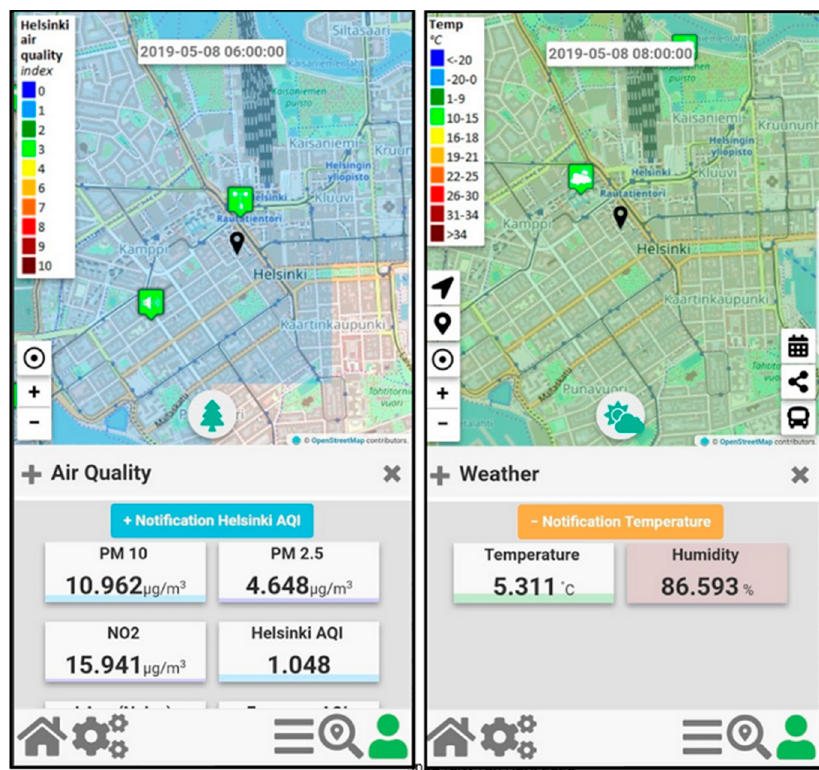
Figure 6. Mobile App Helsinki in a Snap, visualization of Heatmap and subscription to alerts.